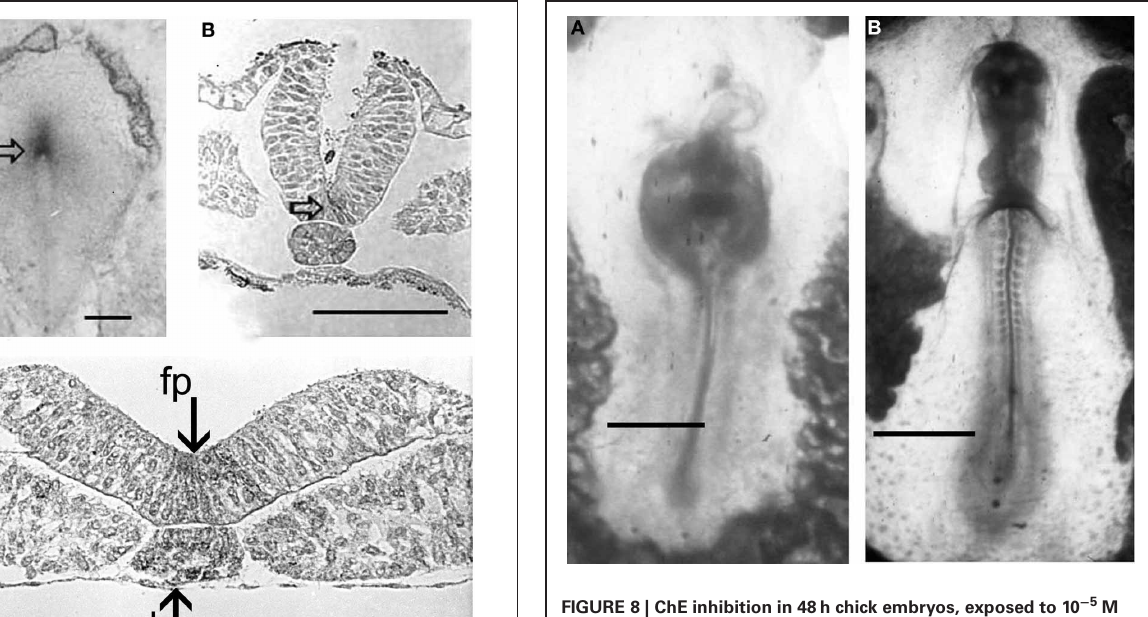
FIGURE 8 | ChE inhibition in 48h chick embryos, exposed to 10 − 5 M diazinon prevents anterior closure of the heart (the head is